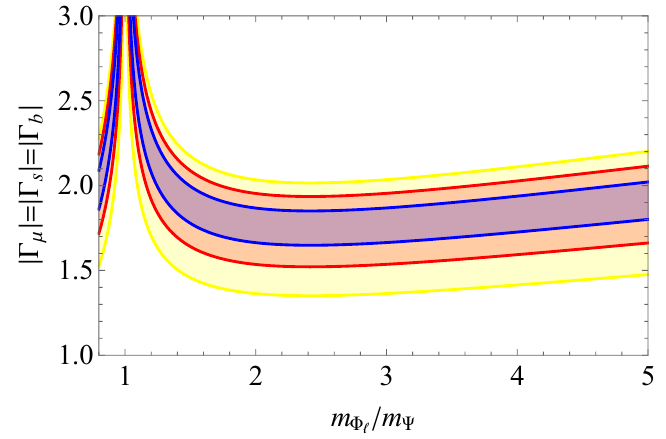
Figure 6 . Allowed regions for the coupling strength to muon, bottom and strange quarks from b ! s(cid:22) + (cid:22) (cid:0) data as a function of m (cid:8) Blue, red and yellow correspond to 1 (cid:27) , 2 (cid:27) and 3 (cid:27) , respectively.